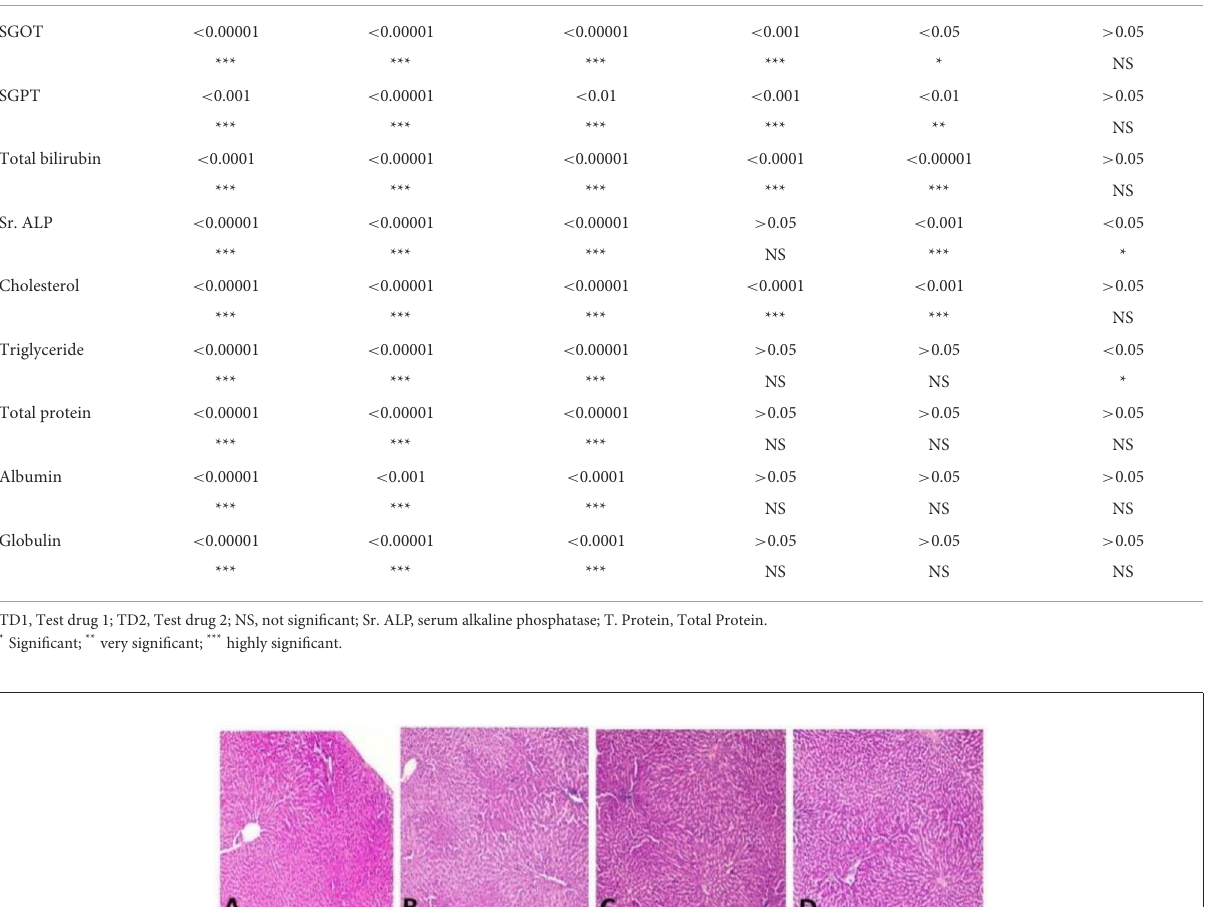
TABLE 9 Comparative results after applying Tukey-Krammer test between groups. Biochemical